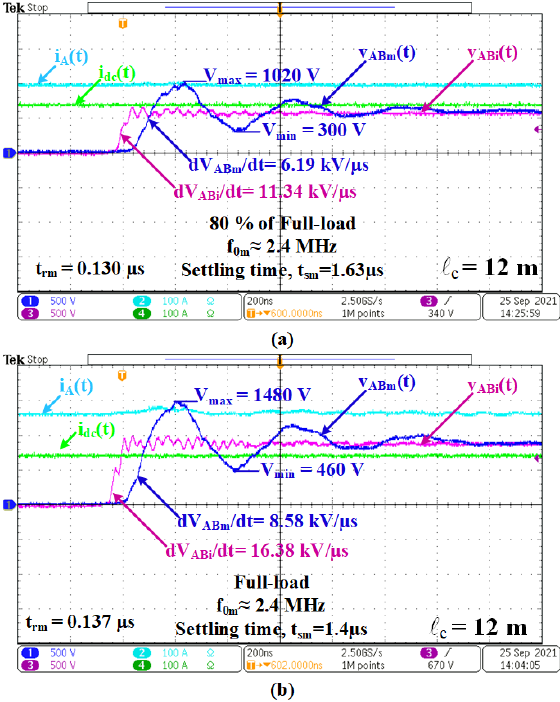
Figure 26. Effects of catenary voltage, V dc , on line-to-line motor voltages. ( a ) V dc = 600 V and at 80% of full load and ( b ) V dc = 900 V and full load.